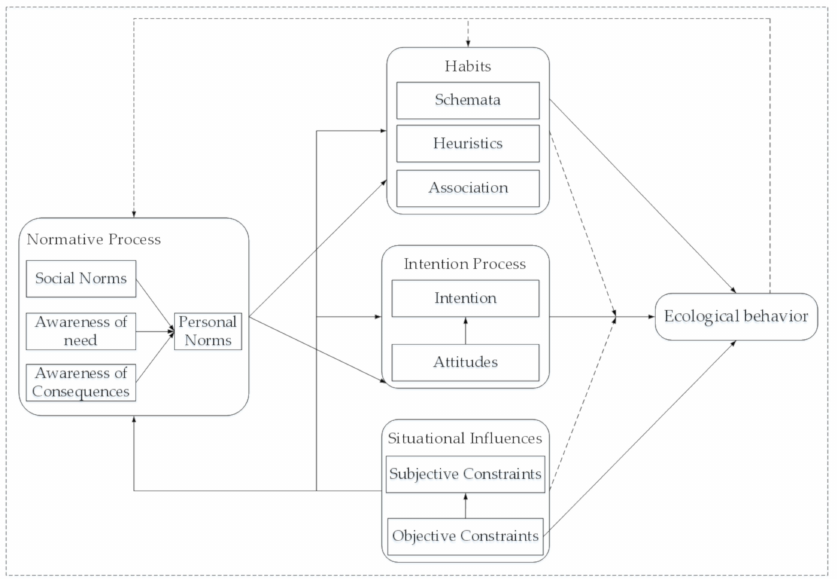
Figure 3. A comprehensive action determination